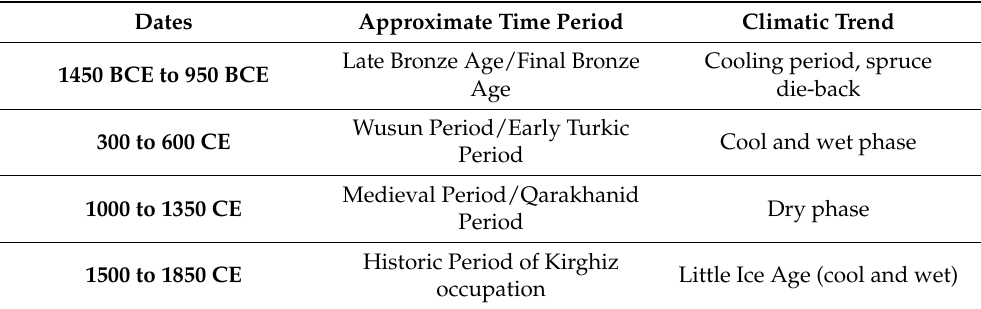
Table 2. Dates, Time Periods, Climatic Trends on the South side of Lake Issyk Kul according to Pollen Cores from the Karakol area